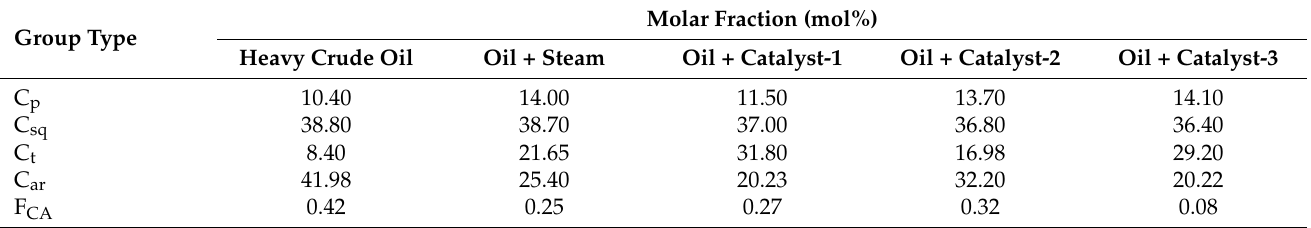
Table 8. Molar Fraction (%) of carbon groups of resins before and after the upgrading process. Group Type